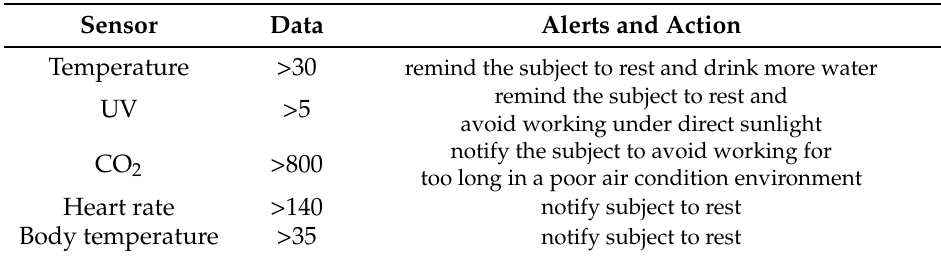
Table 3. Examples of safety alert using different sensors’ data.